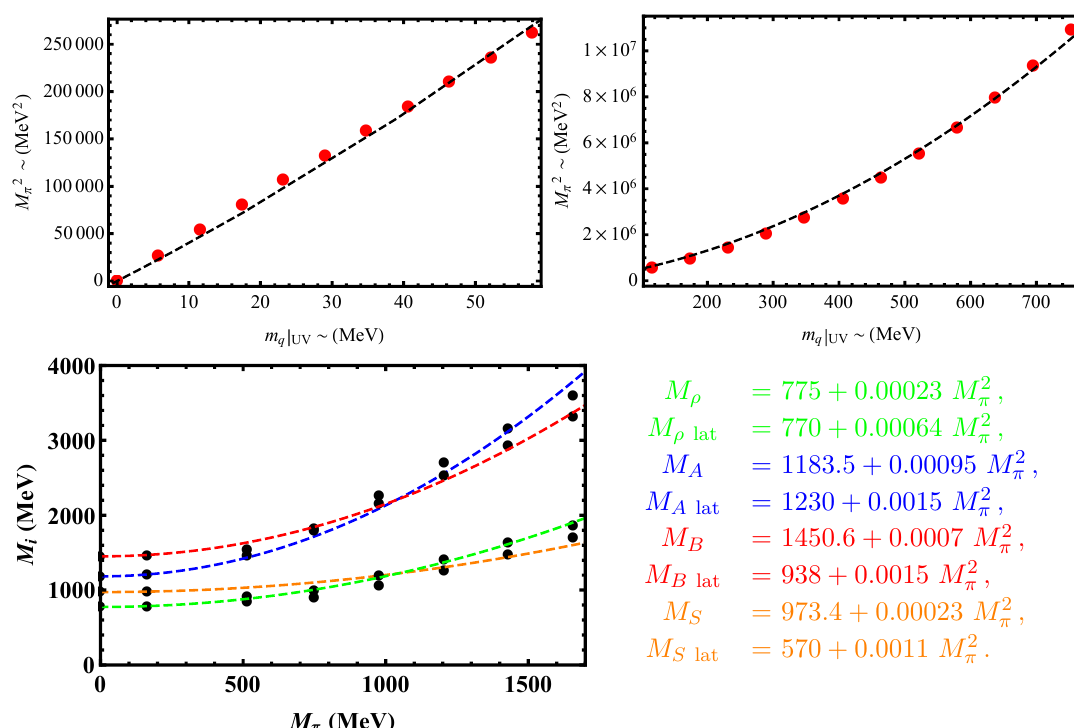
Figure 2. The top figures show the pion mass squared aginst the UV quark mass. The dashed black lines show the fit we obtained which is given by M 2 the pion mass is given in MeV. The bottom plot shows the other meson and baryon masses against M π and the best fits obtained in our model. In these formulae the pion mass is also given in